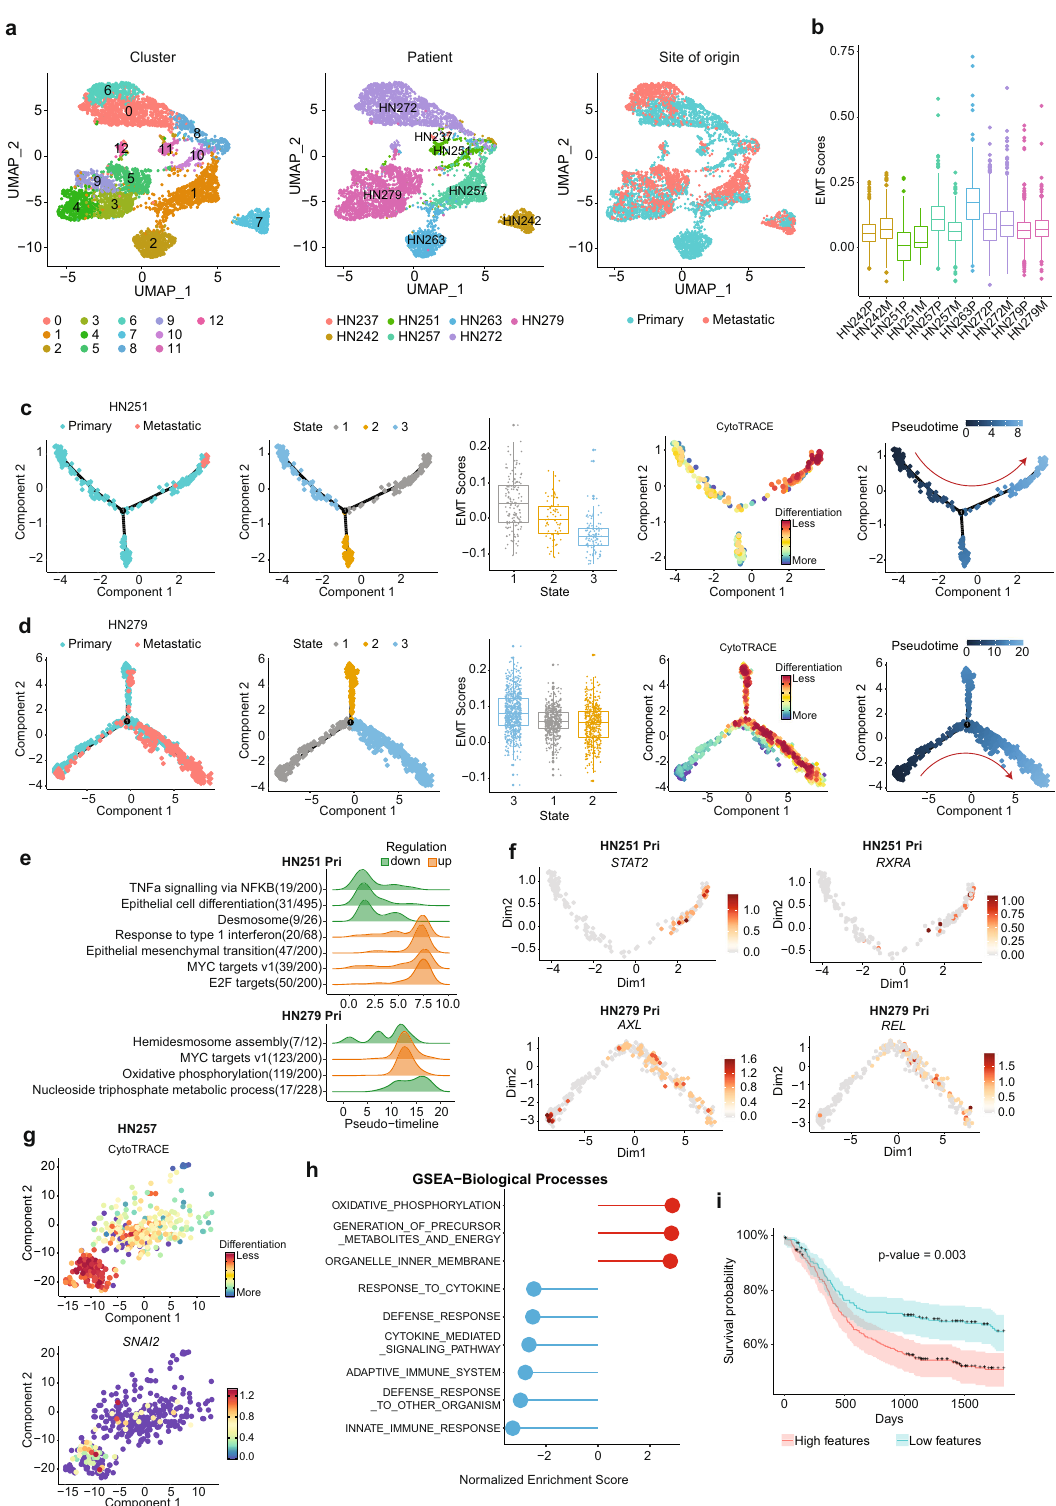
Hemidesmosome assembly(7/12) MYC targets v1(123/200) Oxidative phosphorylation(119/200) Nucleoside triphosphate metabolic